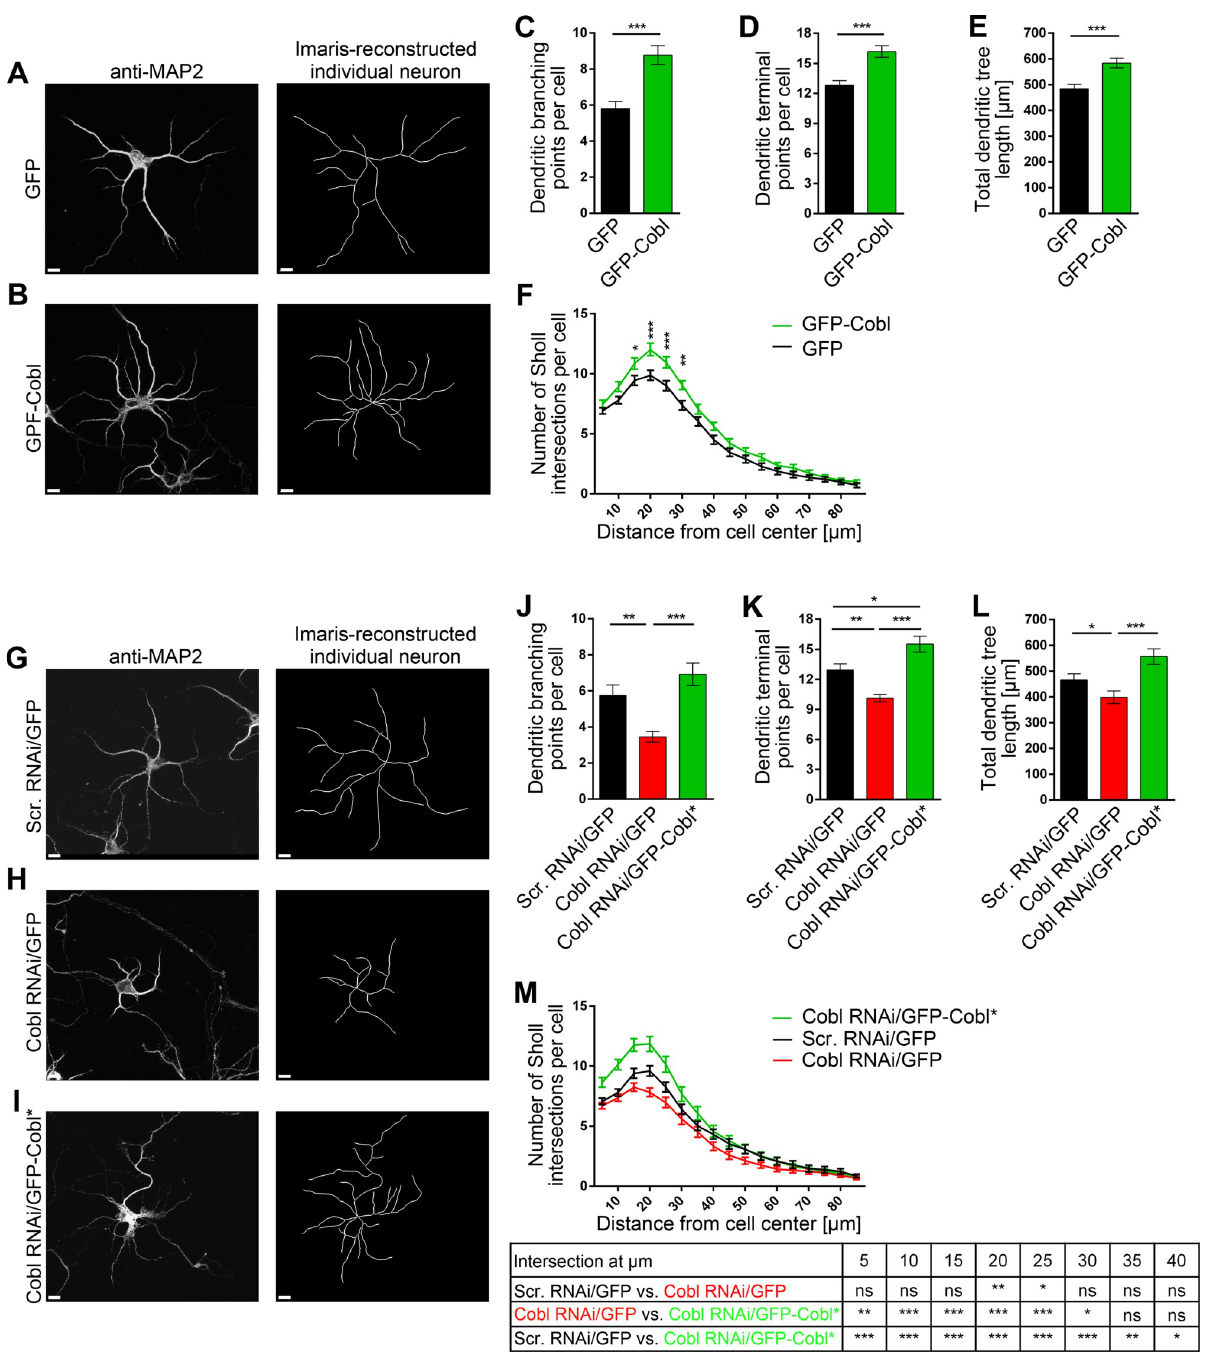
Fig 6. The actin nucleator Cobl promotes and is critical for dendritic arborization during early development of cultured primary rat cortical neurons. A, B , Representative MIPs of anti-MAP2-immunostained (left panels) and Imaris-reconstructed primary rat cortical neurons (right panels) that were transfected at DIV4 with either GFP ( A ) and GFP-Cobl ( B ), respectively, and fixed 40 hours later. Scale bars, 10 μ m. C–F , Quantitative determinations of dendritic arborization parameters unveiling clear Cobl gain-of-function phenotypes. Note that dendritic branching points ( C ), dendritic terminal points ( D ), total dendritic tree length ( E ), and Sholl intersections ( F ) were all increased upon Cobl overexpression, respectively. G–I , Representative MIPs of anti-MAP2-immunostained (left panels) and Imaris-reconstructed primary rat cortical neurons (right panels) that were transfected at DIV4 with plasmids encoding for either GFP-reported scrambled RNAi (Scr. RNAi/GFP) ( G ), Cobl RNAi/GFP ( H ) and Cobl RNAi together with silently mutated Cobl rendered insensitive again Cobl RNAi (Cobl RNAi/GFP-Cobl � ) ( I ), respectively, and fixed 40 hours later. Scale bars, 10 μ m. J–M , Quantitative determinations of dendritic arborization parameters unveiling clear and specific Cobl loss-of-function phenotypes.